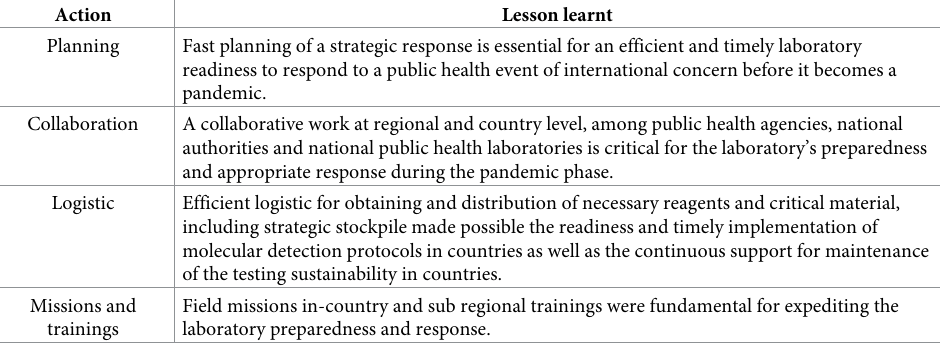
Table 2. Summary of main lessons learnt on laboratory response for preparing to a pandemic.